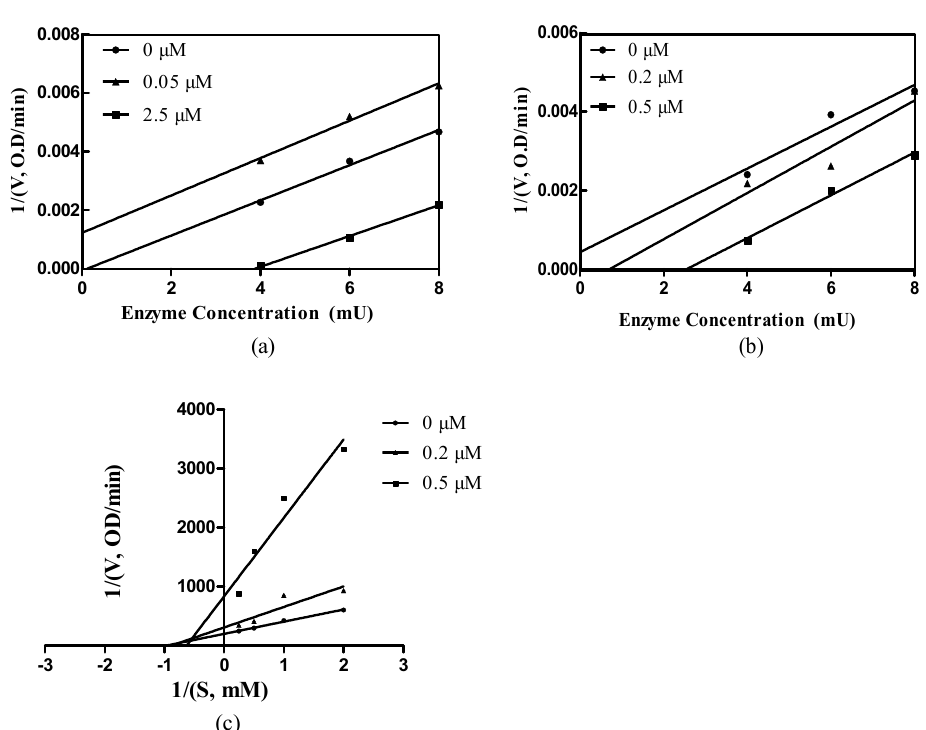
Figure 2. Inhibitory kinetics of 4d and 5d on α -glucosidase. ( a ) The interactions of 4d and α -gluco- sidase ( ● , 0 μ M; ▲ , 0.05 μ M; ■ , 2.5 μ M). ( b ) The interactions of 5d and α -glucosidase ( ● , 0 μ M; ▲ , 0.2 μ M; ■ , 0.5 μ M). ( c ) Lineweaver–Burk plots for inhibition of 5d ( ● , 0 μ M; ▲ , 0.2 μ M; ■ , 0.5 μ M).